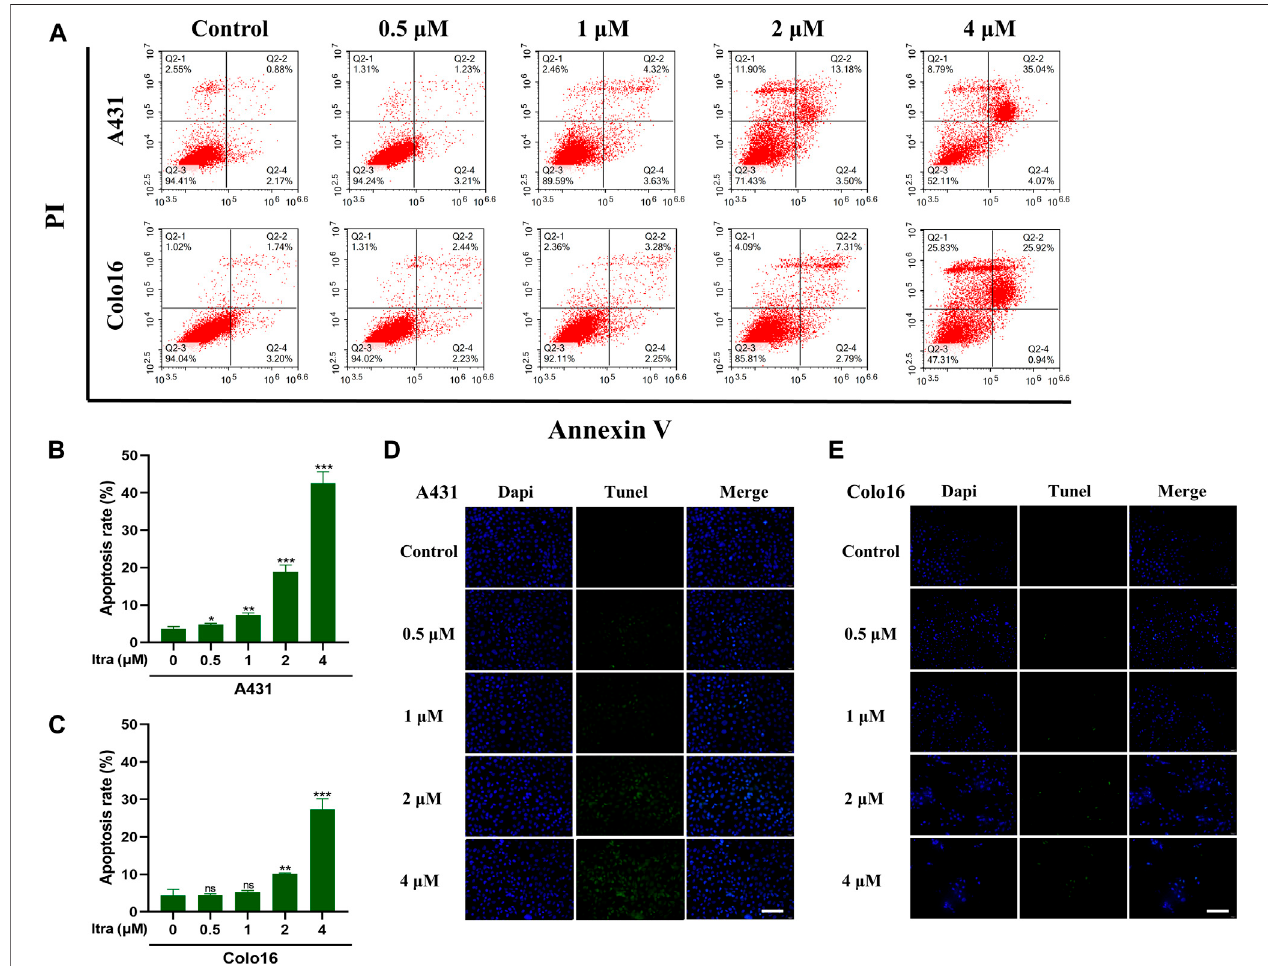
FIGURE 2 | Itraconazole induced apoptosis in cSCC cells. (A – C) Cell apoptosis at different itraconazole concentrations, as determined using fl ow cytometry. [mean±SD(errorbars), n =3;* p ≤ .05;** p ≤ .01;*** p ≤ .001,comparedwithcontrolgroup] (D,E) TUNELmeasurementofapoptosisinA431andColo16cellsvisualized with a fl uorescent microscope (Scale bar: 100 μ